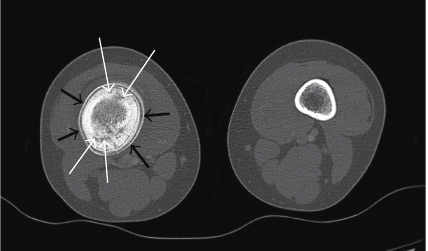
Figure 2: Axial 1.25 mm image enhanced CT through the lesion. The right femoral lesion is well shown on CT, including cortical thickening, cortical lucencies (thin white arrow), and periosteal reaction (black arrows). Note the size discrepancy between the right and left femurs in keeping with the clinically seen asymmetry and fusiform